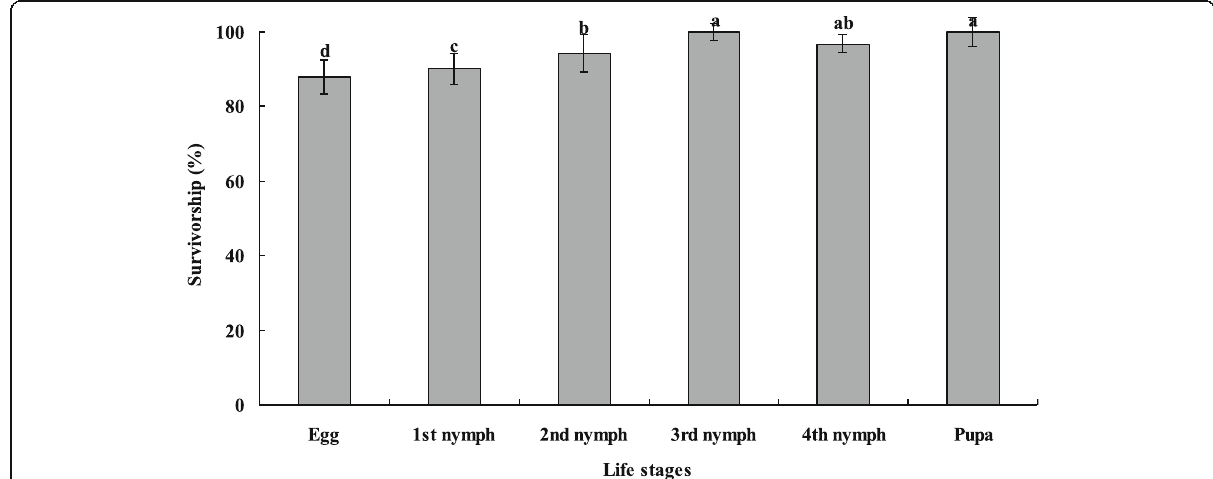
Fig. 2 Percent survival of Clitostethus brachylobus immatures. Bars marked by different letters are significantly different from each other (Tukey ’ s P < 0.05)